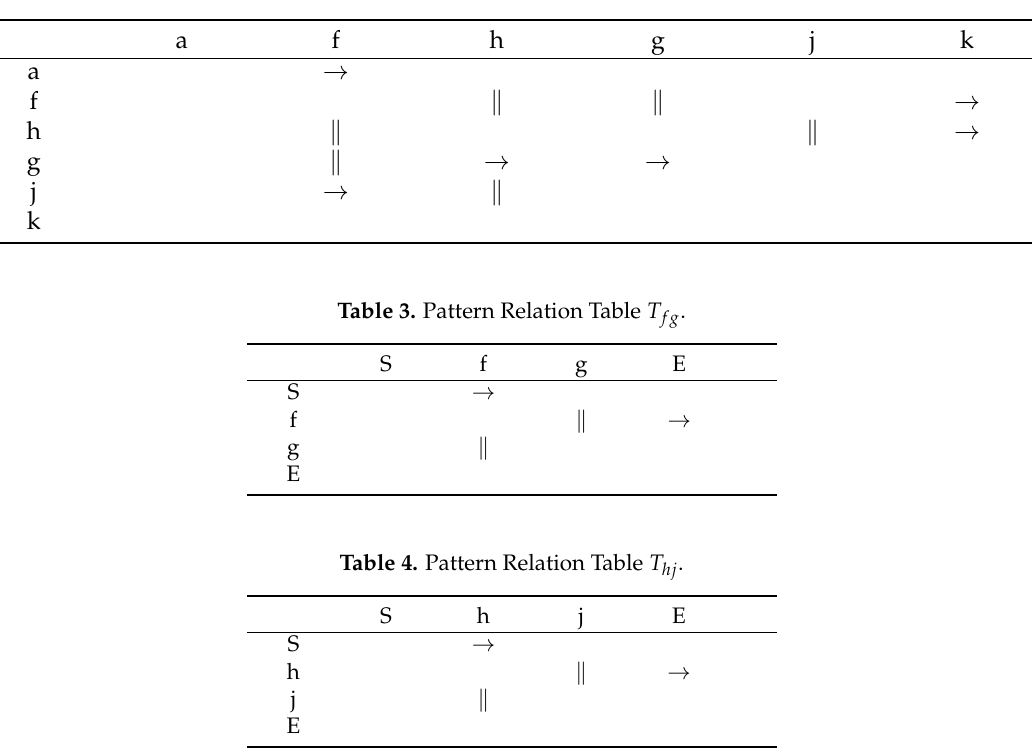
Table 2. Pattern Relation Table T 0 .